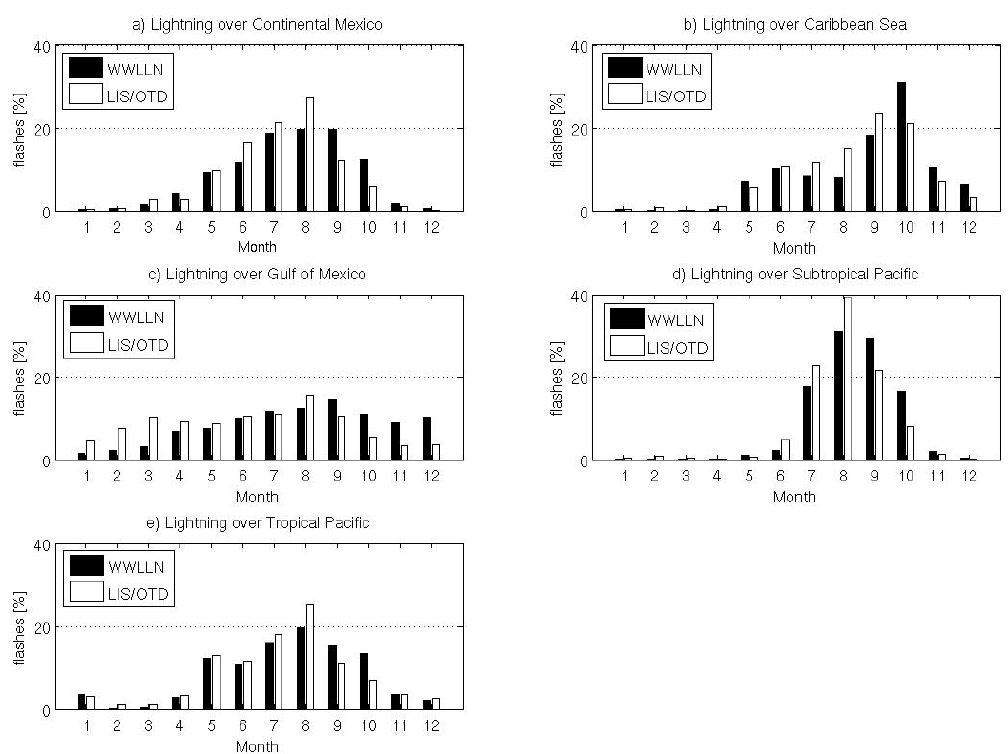
Fig. 5. Average seasonal cycle of lightning strokes in percentage for (a) continental Mexico, (b) Caribbean Sea, (c) Gulf of Mexico, (d) Subtropical Pacific and (e) Tropical Pacific. Bars in black represent the 5-year average obtained from the WWLLN dataset during the period 2005–2009. Bars in white indicate the total lightning recorded by OTD and LIS from 1995 to